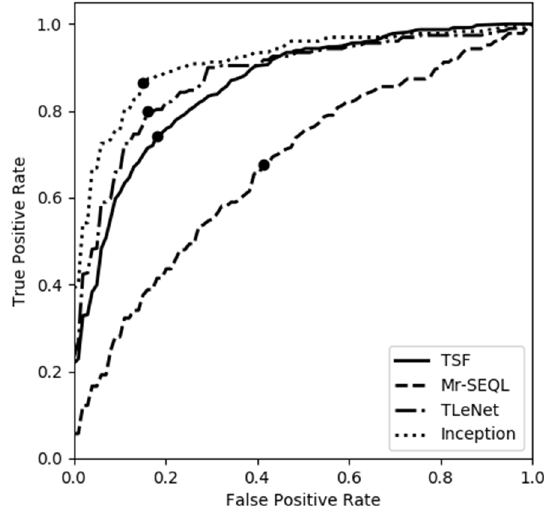
Figure 2. The receiver operating characteristic curve (ROC) for the machine learning (TSF and Mr- SEQL) and deep learning (TLeNet and Inception) models. The true positive rate is the sensitivity, and the false positive rate is 1- specificity. The optimal cutoff is shown as a circle for each model. Among all these models, the Inception model showed the highest specificity and sensitivity, fol- lowed by the TLeNet and TSF models, while the Mr-SEQL model showed the worst performance.